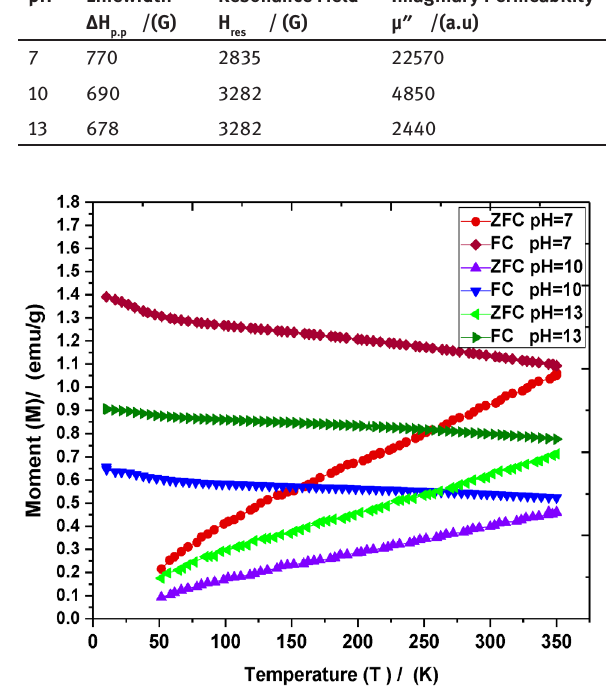
Figure 5: ZFC-FC curves of nano Ni ferrite at pH=7, 10 and